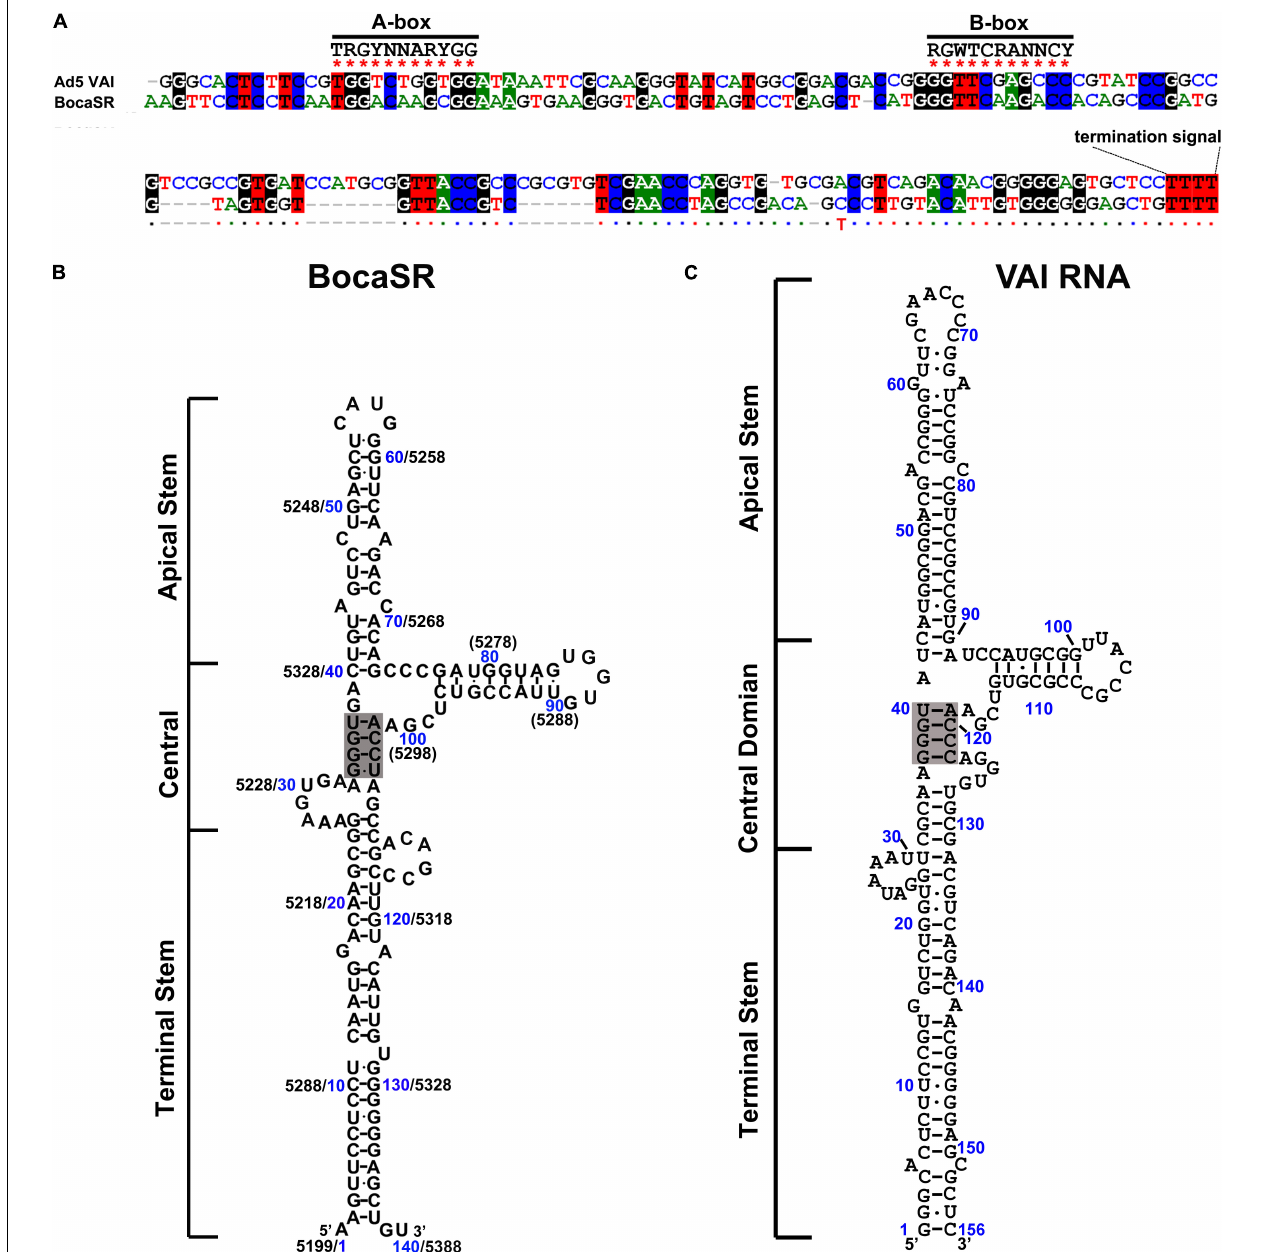
FIGURE 3 | Comparisons between BocaSR and VAI RNA. (A) RNA sequence alignment. The sequences of BocaSR and adenovirus 5 (Ad5) VAI RNA were aligned using the CLUSTALW algorithm. Identical nucleotides are colored. Consensus sequences of the A- and B-boxes of the intergenic RNA Pol III are indicated. R represents G/A; Y, C/T, and N any nucleotides. (B,C) The structure of BocaSR (B) was predicted using the KineFold algorithm, with Ad5 VAI RNA serving as a reference (C) . Nucleotide numbers shown in blue and black are the positions of the BocaSR RNA (VAI RNA) sequence and the HBoV1 genome, respectively. Stem structures are indicated, and the central tetranucleotide pairs are highlighted in